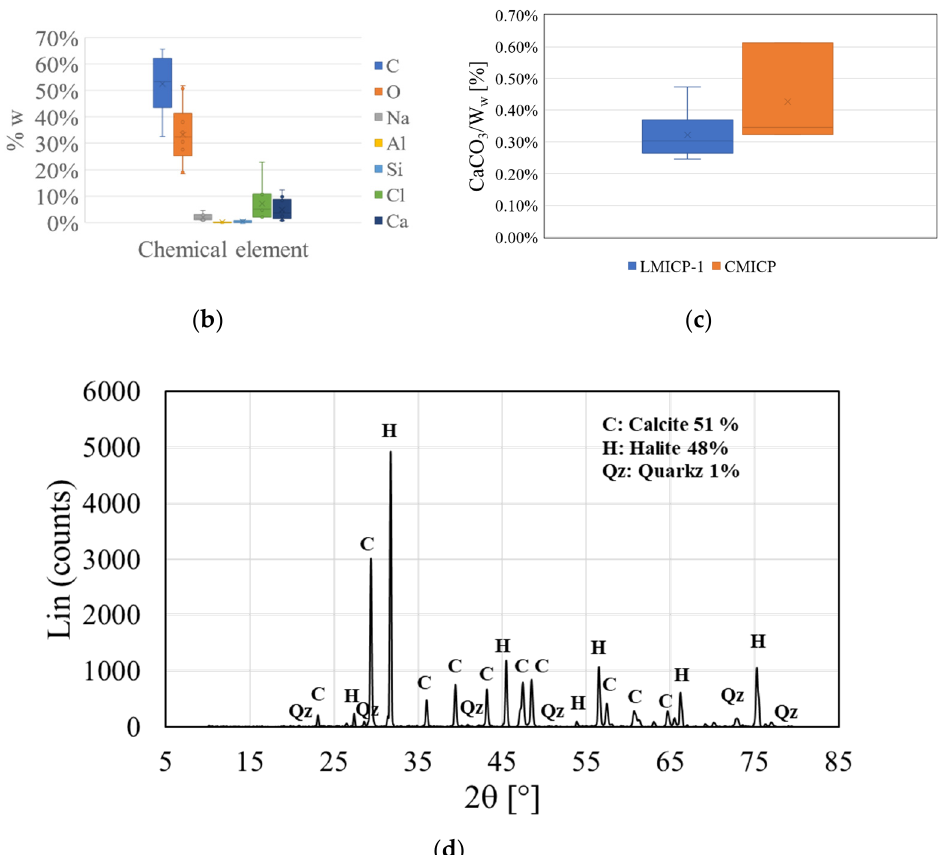
Figure 4. Characterization of the bio-product: ( a ) SEM image; ( b ) energy-dispersive X-ray spectroscopy results; ( c ) proportion of CaCO 3 in LMICP-1 and CMICP solutions; ( d ) X-ray diffraction.